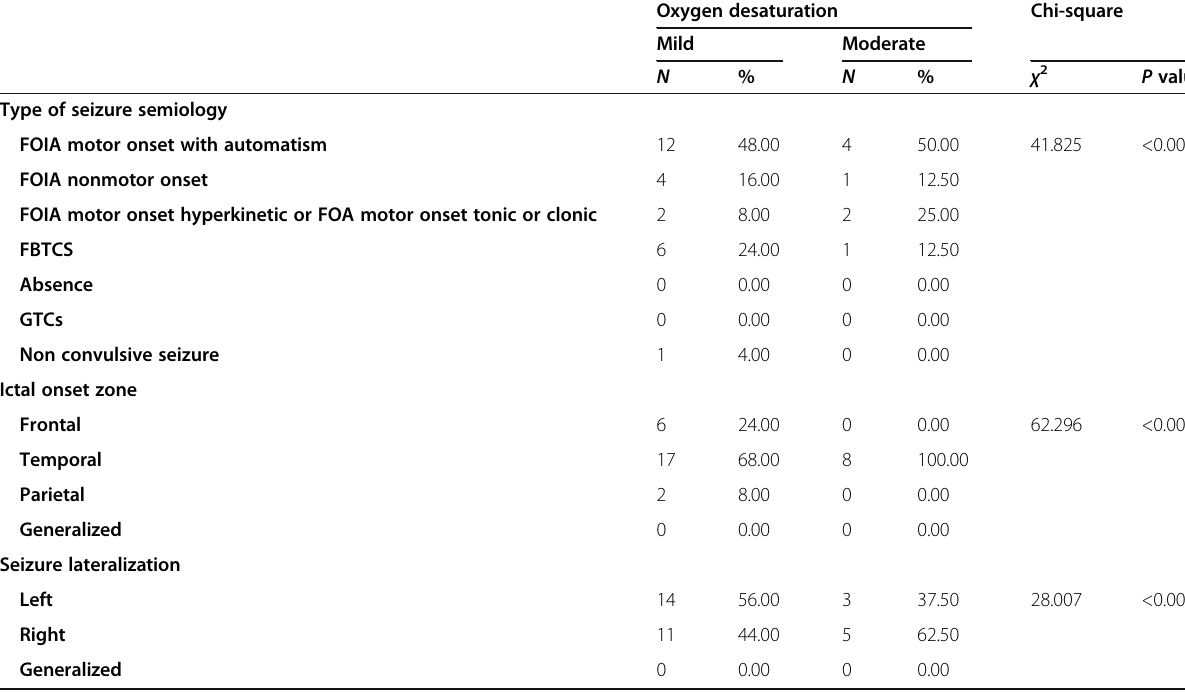
Table 3 Correlations between oxygen desaturation and seizure semiology, lateralization, and ictal onset zone Oxygen desaturation Chi-square